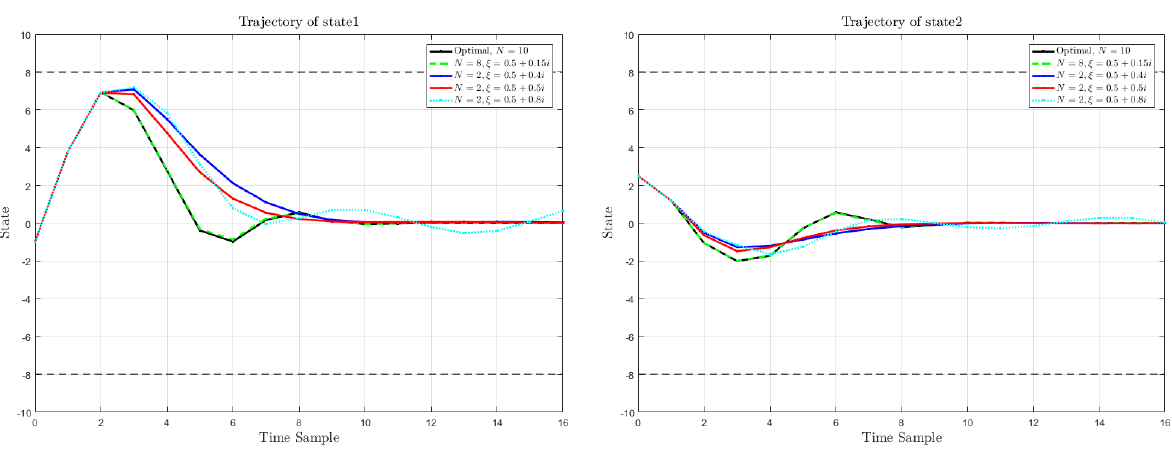
Figure 4. State evolution for different Kautz Characteristics